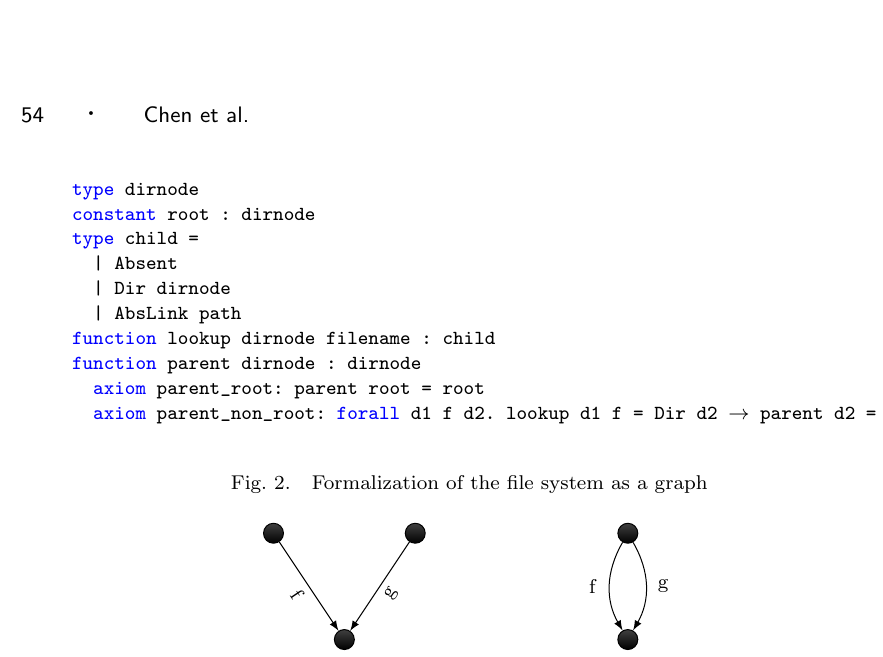
Fig. 3. Parent of a dirnode must be unique. Shape at left is forbidden whereas shape at right is allowed. type filename type pathcomponent = Down filename | Up | Here type path = list